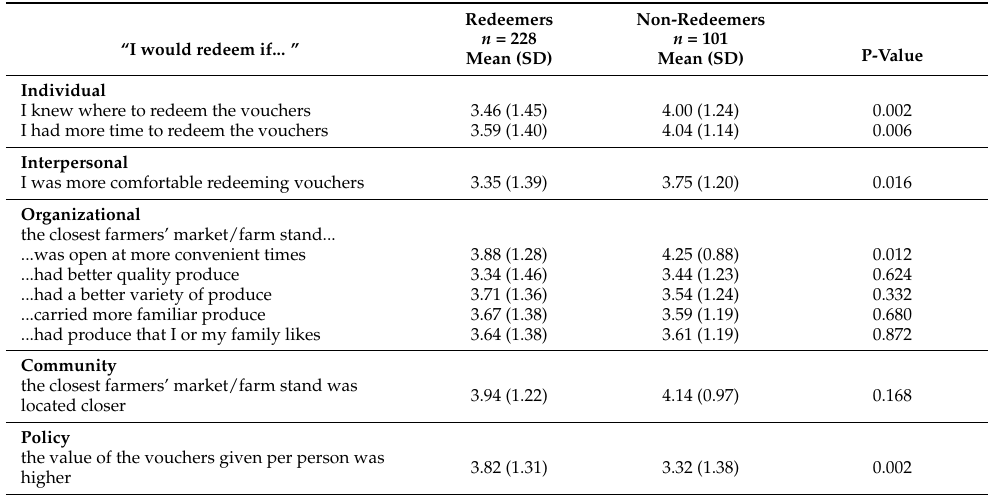
Table 4. Facilitators of FMNP Redemption.